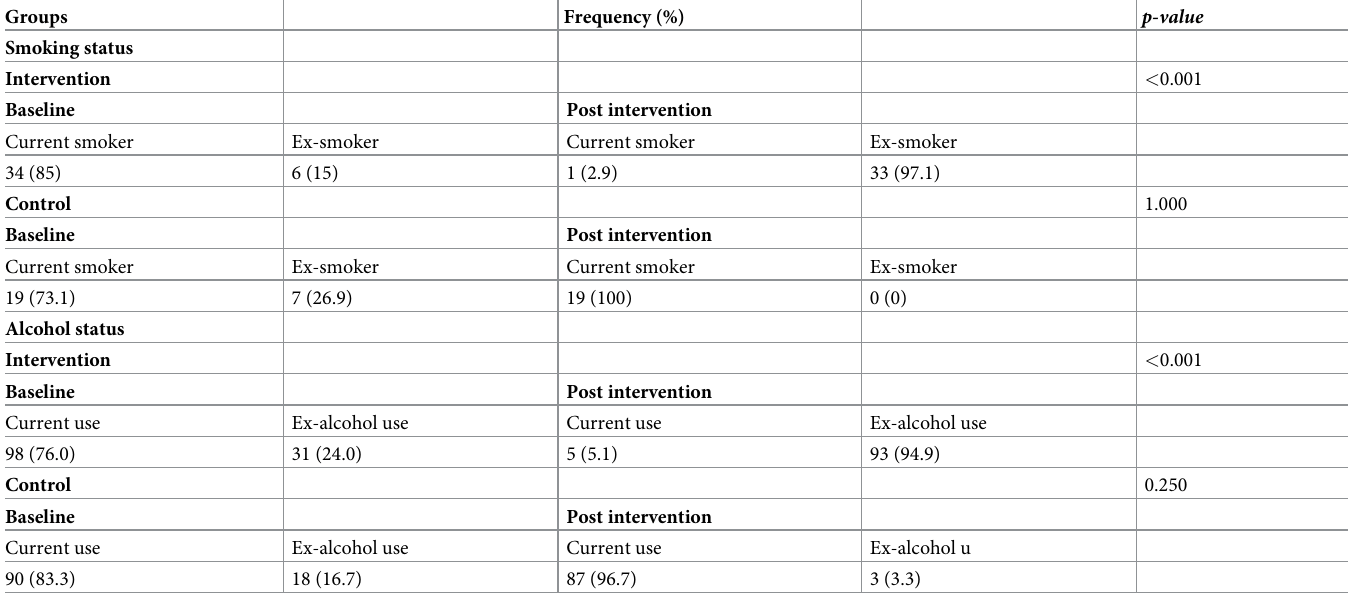
Table 5. Change in frequency of smoking and alcohol statuses from baseline to post